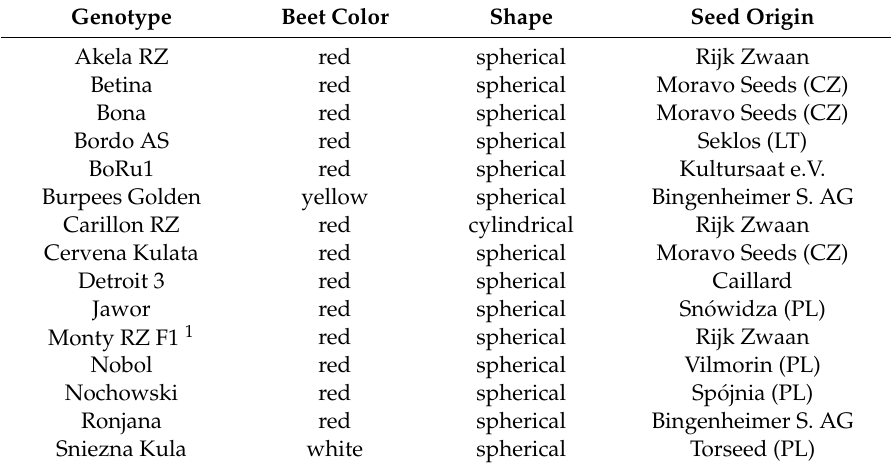
Table 1. List of the 15 studied beetroot genotypes (beet shape and color, and seed origin). Genotype Beet Color Shape Seed Origin Akela RZ